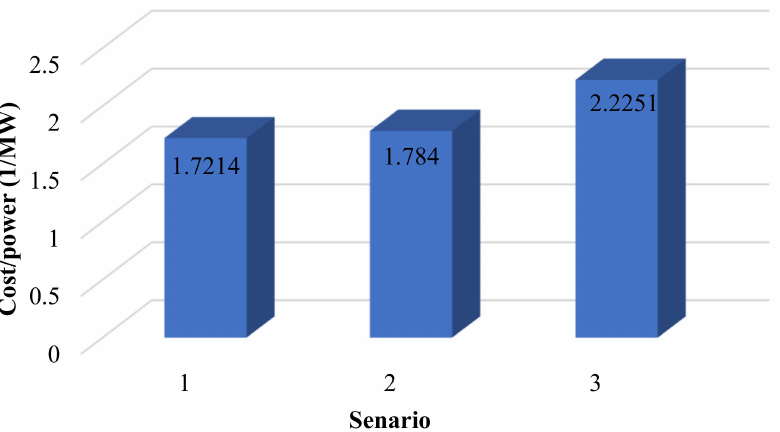
Figure 17. The objective function of three cases.